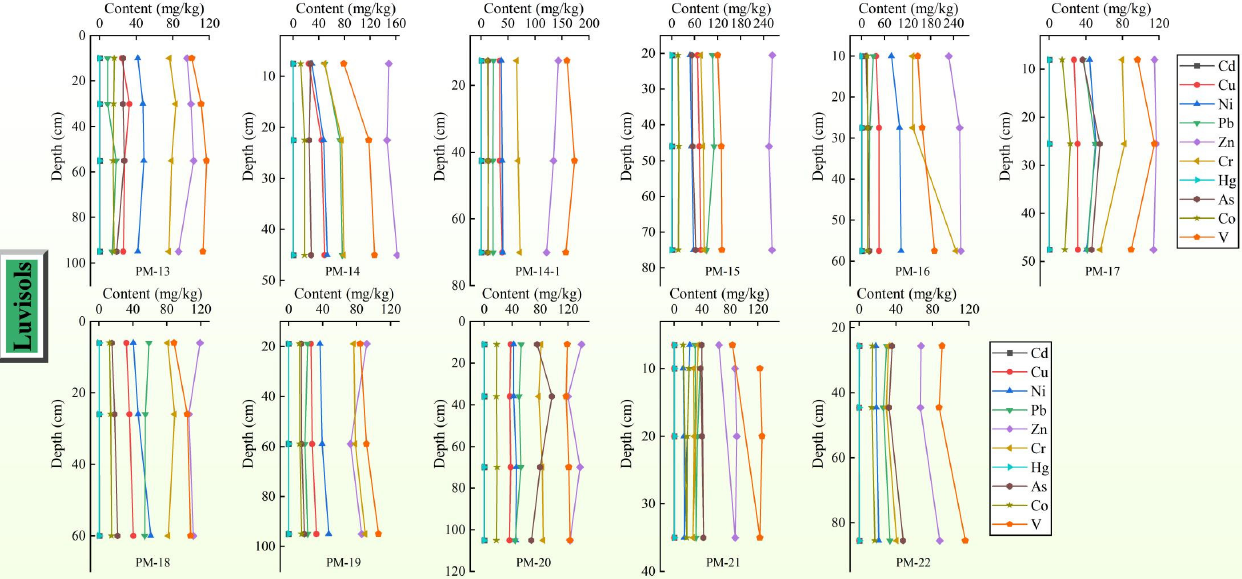
Figure 7. Distributions of HM (Cd, Hg, Cu, Ni, Pb, Zn, Cr, As, Co, and V) in the Luvisols profile ( N = 11).